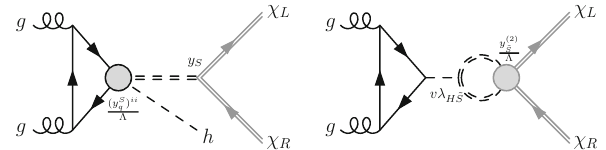
Fig. 7 Potentially important loop diagrams contributing to DM inter- actions in the e DMeft , turning on the operators ∼ ( y S q ) ij and ∼ y S , or ( 2 ) ∼ λ and ∼ y ˜ S , respectively. The right diagram involves the quartic H ˜ S portal term ∼ λ , which is basically the only relevant term that allows H ˜ S to produce scalar DM via a (pair-produced) pseudo-scalar mediator at the D ≤ 5 level (via a similar diagrams with y for details